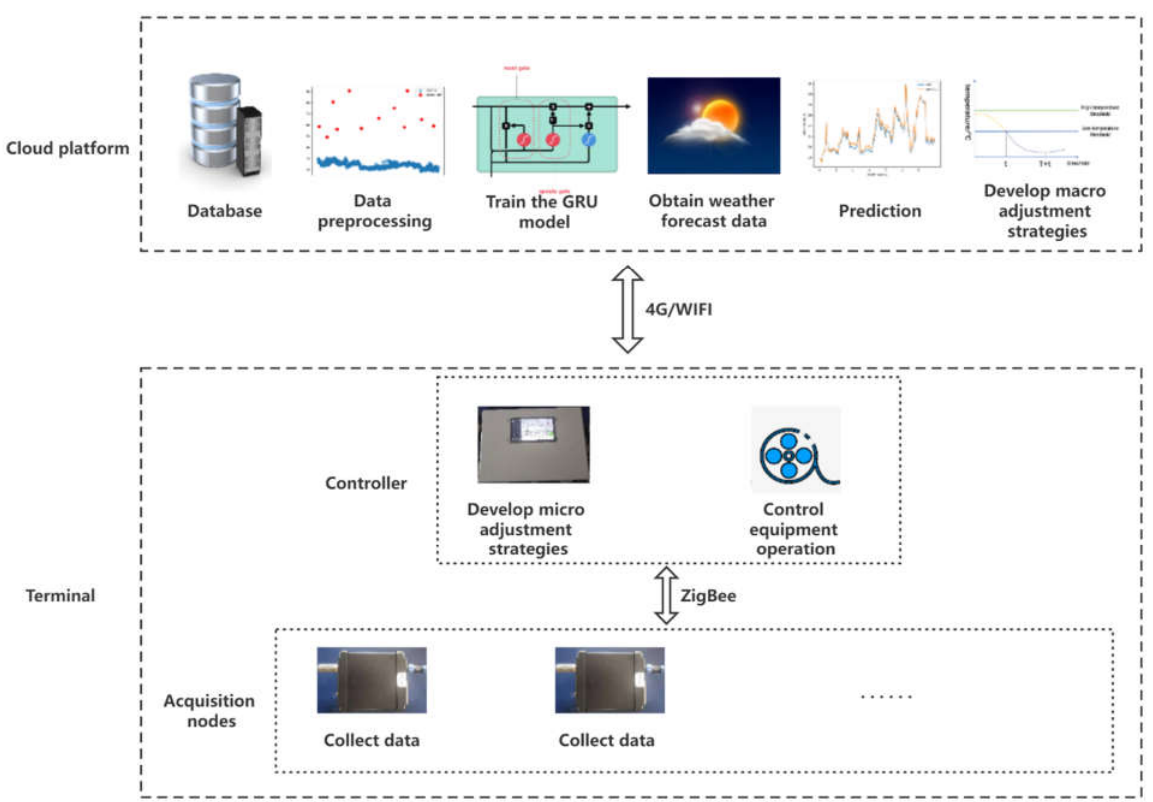
Figure 8. System framework. The framework of the system is mainly divided into two parts: cloud platform and terminal equipment.